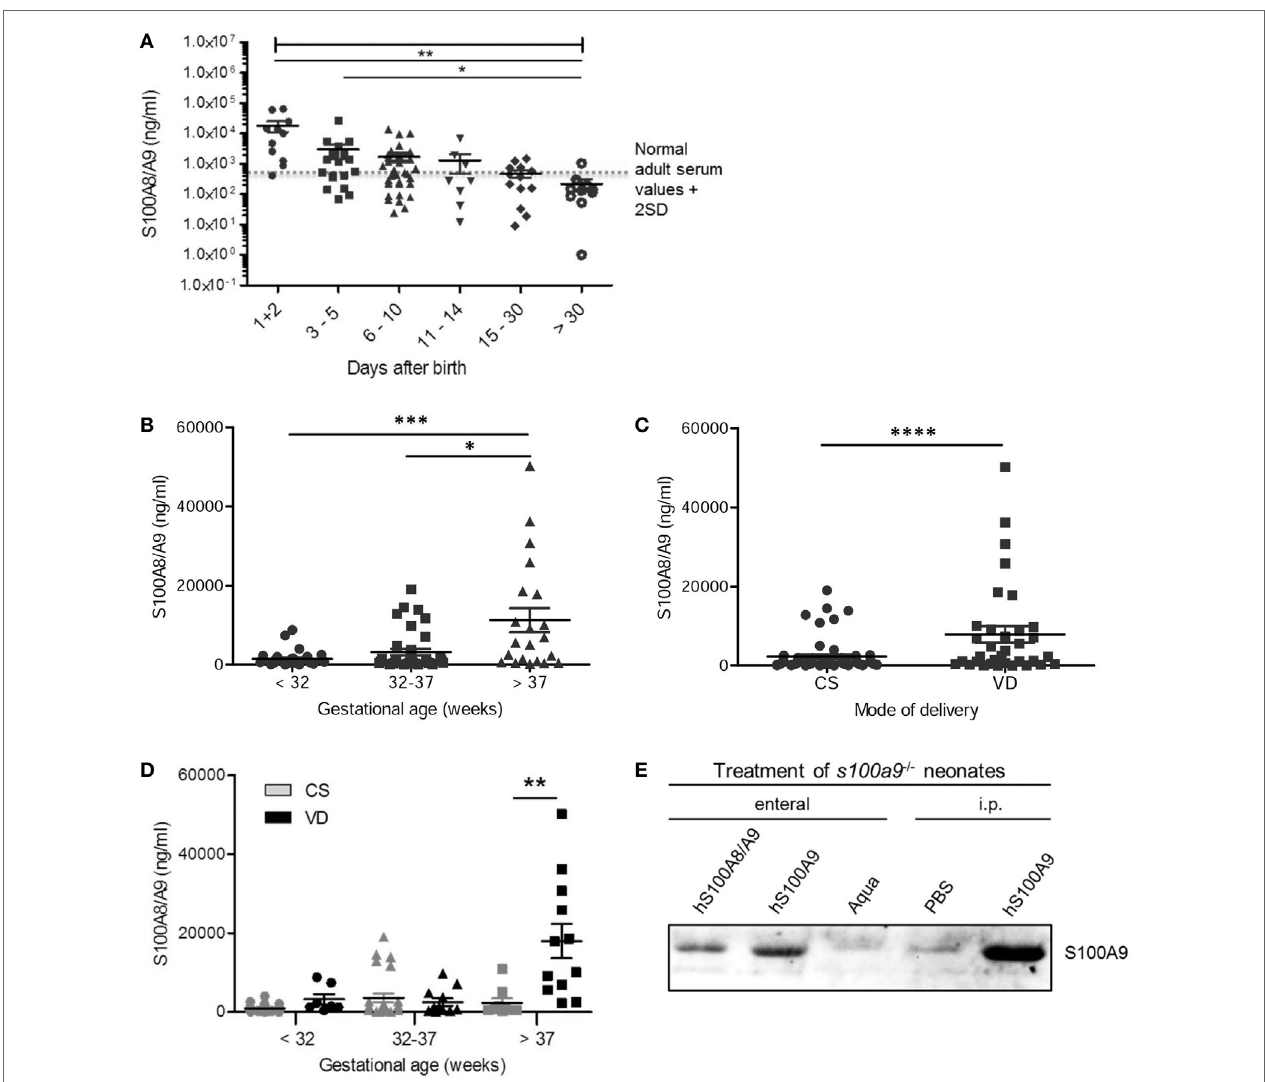
FigUre 1 | Levels and bioavailability of S100A8/A9 in human breast milk (BM). (a) Postnatal course of S100A8/A9 levels in human BM. Bars on a logarithmic scale represent means ± SEM. Significant differences are indicated by capped-end lines across groups ( p < 0.0005, Kruskal–Wallis test) and open lines (* p < 0.05 and ** p < 0.0005, post hoc Mann–Whitney U -test). (B–D) Mean S100A8/A9 levels in human BM during the first 30 days were categorized according to the baby’s gestational age (B) , the mode of delivery (c) , and the mode of delivery within the different gestational age groups (D) . Bars represent means ± SEM. * p < 0.05, ** p < 0.01, *** p < 0.005, and **** p < 0.0005, t -test. CS, Cesarean section; VD, vaginal delivery. (e) S100A9 immunoblotting of plasma from s100a9 − / − neonates collected 24 h after enteral feeding of hS100A8/A9, hS100A9, or aqua. Intraperitoneal (i.p.) injection of hS100A9 and phosphate-buffered saline served as positive and negative